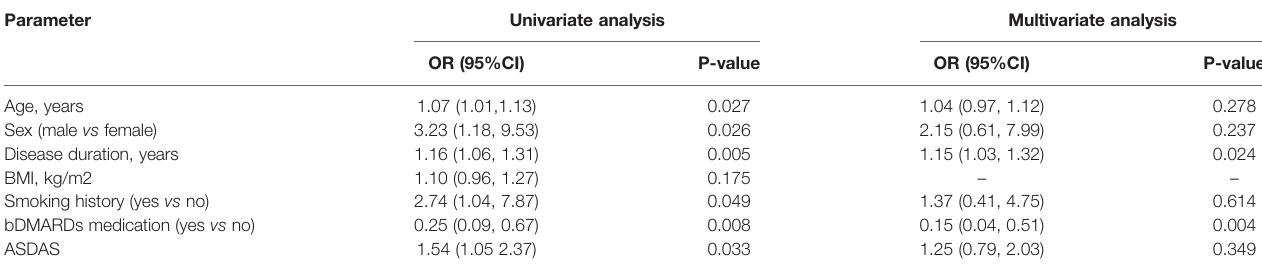
TABLE 7 | Logistic regression analysis for the association between extensive fat deposition in the SIJs of axSpA patients and clinical predictors. Parameter